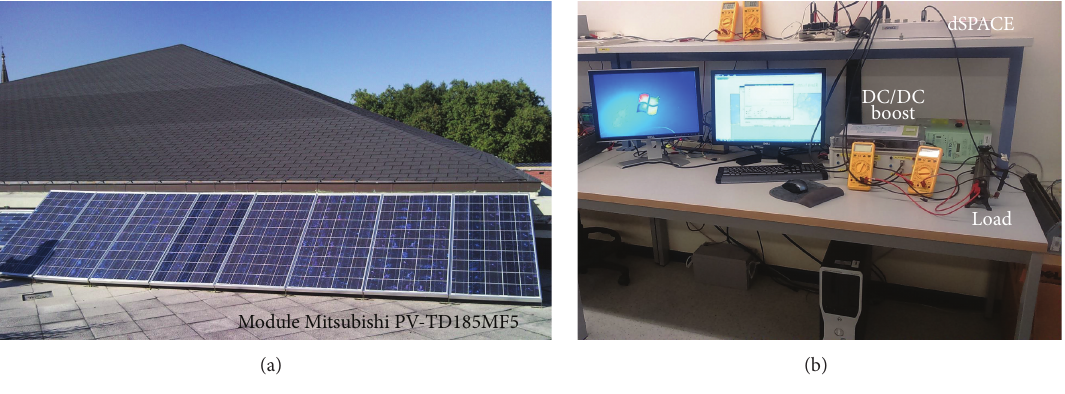
Figure 22: Picture of the actual installation.